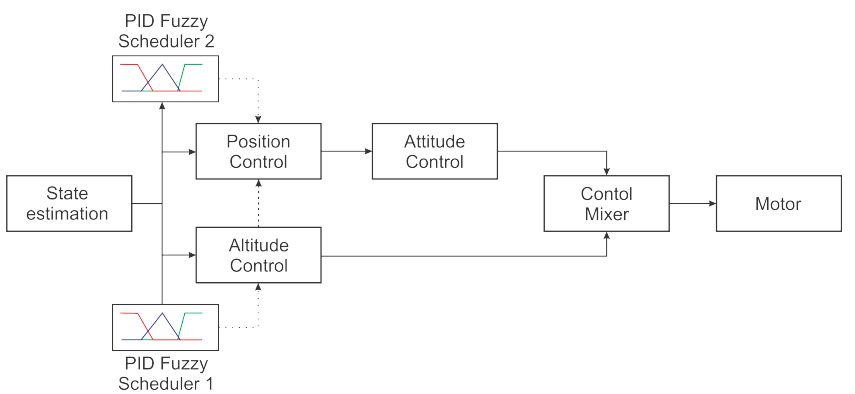
Figure 2. Proposed